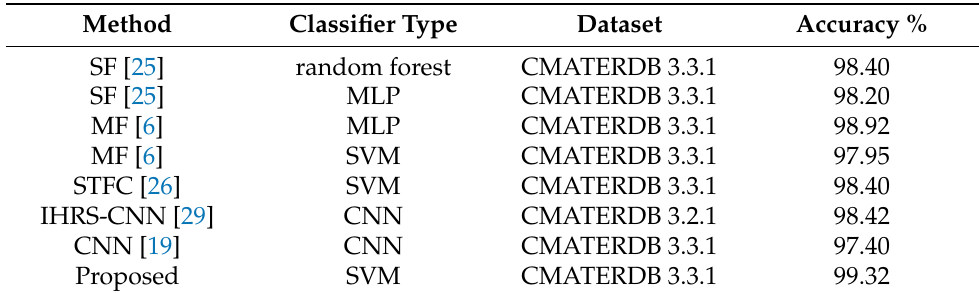
Table 4. Comparison between the proposed method and the state-of-the-art methods for Arabic numeral recognition in clean